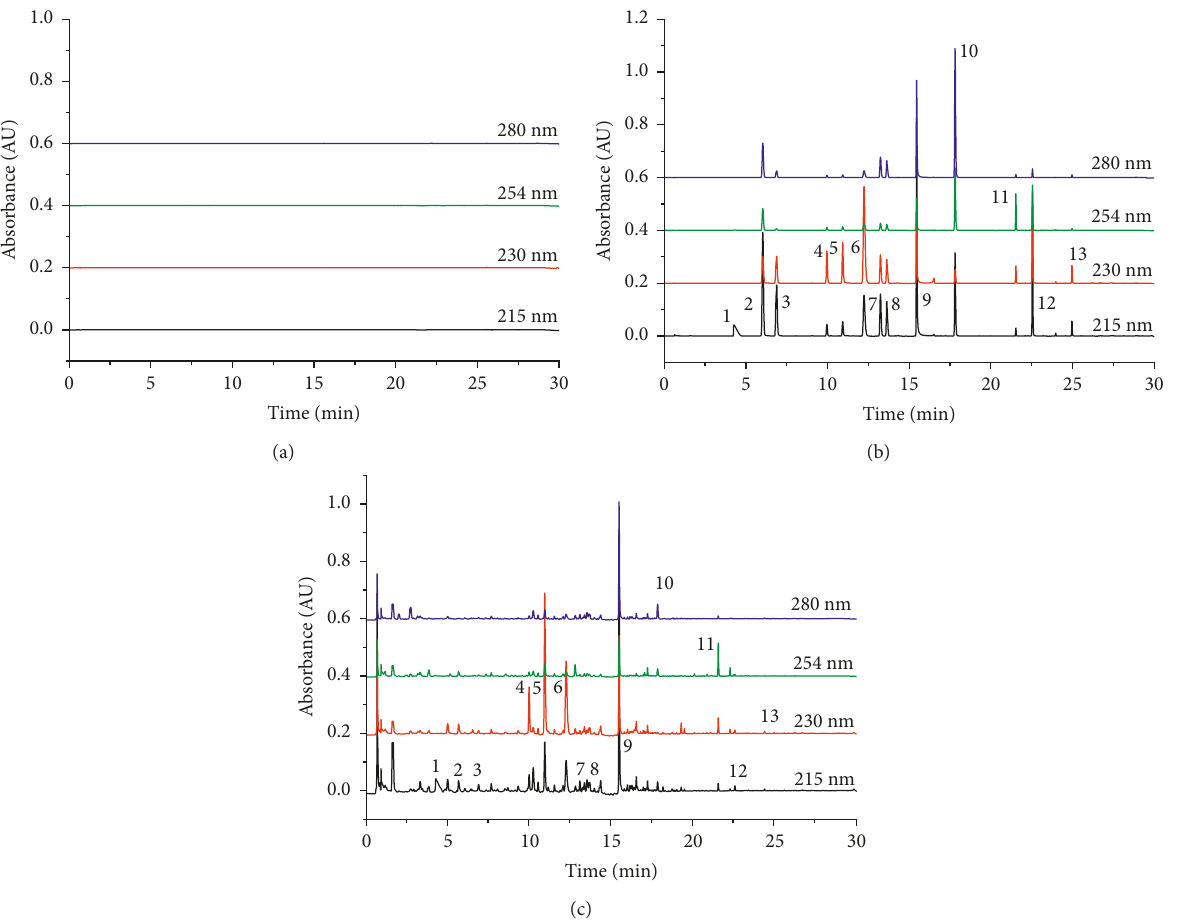
Figure 2: UPLC chromatograms of the (a) blank solvent, (b) standard mixture, and (c) SCRT